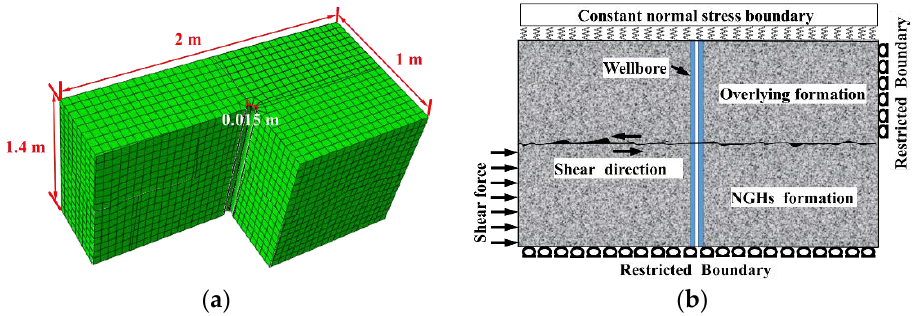
Figure 7. Calculation model: ( a ) model size; ( b ) model boundary conditions. Table 2. Main parameters of the wellbore and rock layer in the numerical simulation [15,28,38].